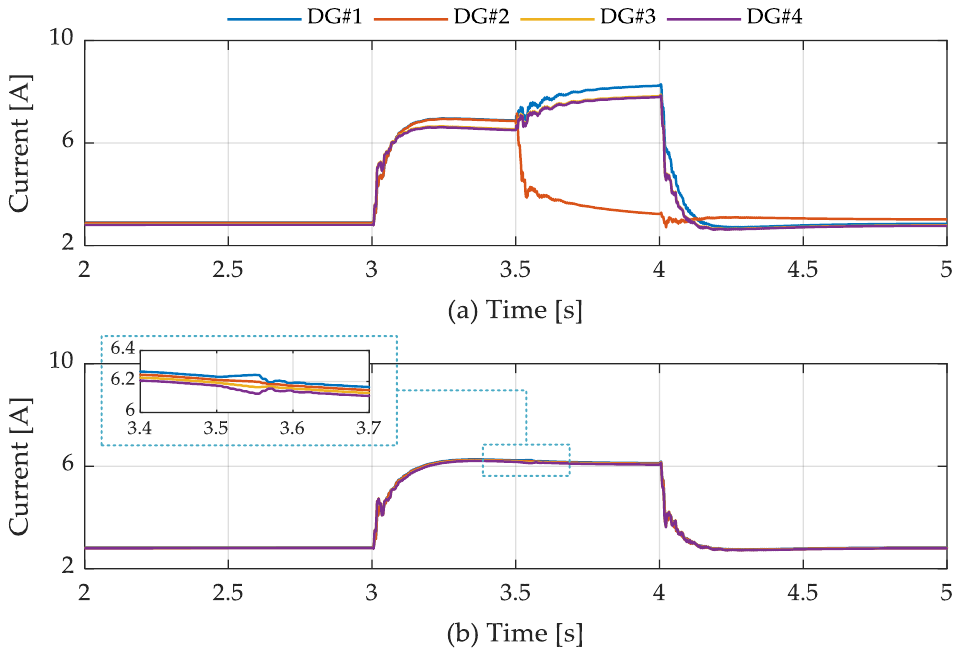
Figure 13. Output current of each DG: ( a ) centralized method; ( b ) proposed method.